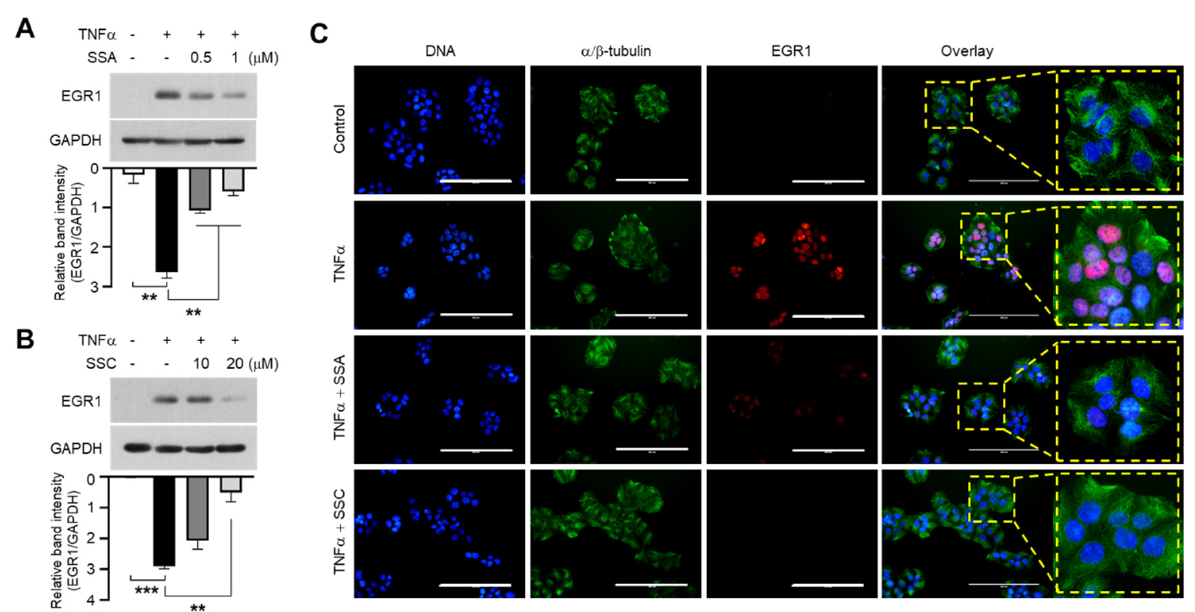
Figure 5. SSA and SSC decrease TNF- α -induced increase in EGR1 protein levels. ( A , B ) HaCaT cells were treated with 10 ng/mL of TNF- α for 1 h in the absence or presence of 0, 0.5, or 1 µM SSA ( A ) and 0, 10, or 20 µM SSC ( B ) . Protein levels of EGR1 were determined by immunoblotting using specific antibodies. GAPDH was used as the internal control. The band intensities of EGR1 were normalized relative to those of GAPDH using ImageJ software. The quantitation data are presented as means ± SD ( n = 3). ** p < 0.01, *** p < 0.001 by Sidak’s multiple comparisons test. ( C ) HaCaT cells, cultured on coverslips, were treated with 10 ng/mL of TNF- α for 1 h in the absence or presence of 1 µM SSA or 20 µM SSC, and immunofluorescence staining was performed using anti-EGR1 (red) and anti- α / β -tubulin (green) antibodies. Hoechst 33258 (1 µg/mL) was used for counterstaining the nuclei (blue). Scale bars, 200 µm.